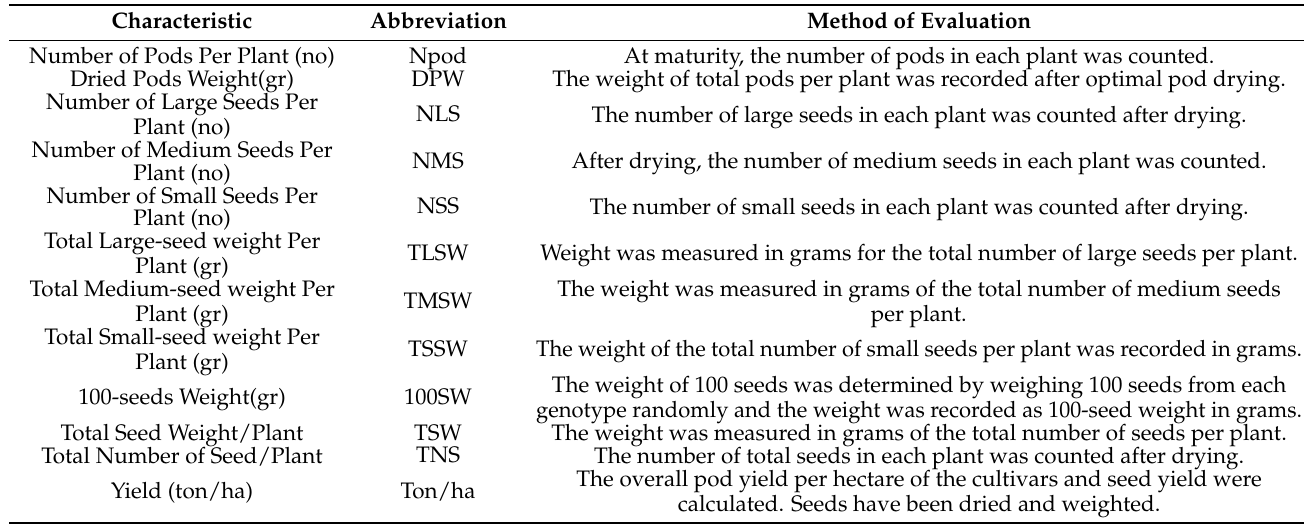
Table 2. Data collection for the yield and yield component traits.